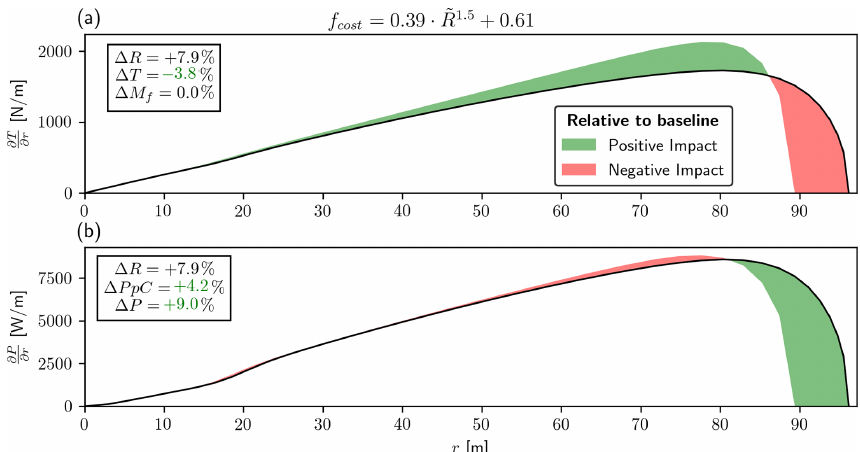
Figure 8. (a) Thrust loading density ( ∂T/∂r ). (b) Power density ( ∂P/∂r ) both as a function of rotor radius ( r ). The green shaded regions show a positive impact relative to the baseline, and red regions show a negative impact. The thing to note is the significant decrease in the loading (a) and how little impact the lower loading has on the power (b) . This is due to the non-linear relationship between C LT and C LP .